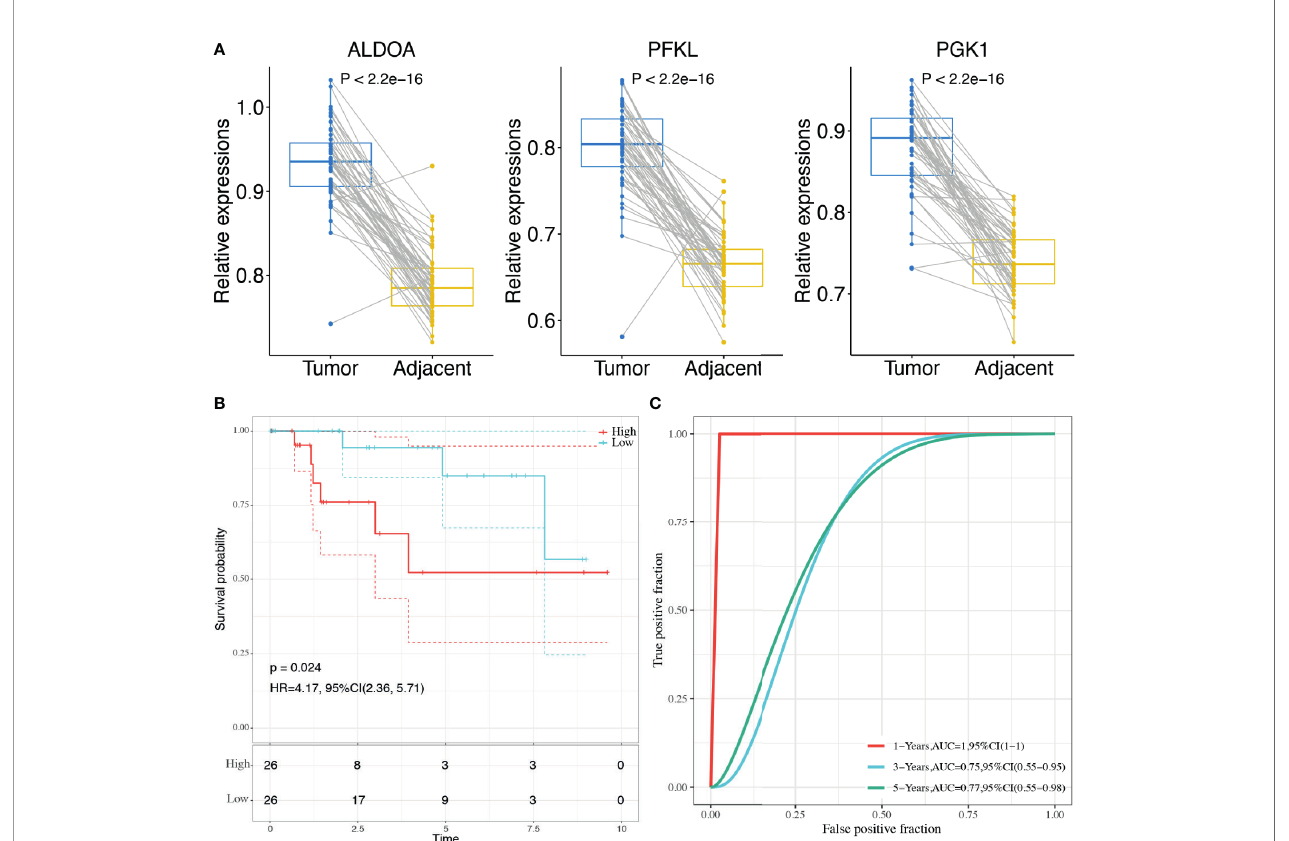
FIGURE 8 | Validation of the HRG-based score model in the BMCHH cohort. (A) Comparisons of the expression levels of 3 genes between TNBC tumor samples and paired adjacent normal samples. (B) K – M survival analysis was performed to estimate the OS of high-risk and low-risk patients. (C) The prognostic performance of 3-gene dHRG signature demonstrated by the ROC curve in the BMCHH validation